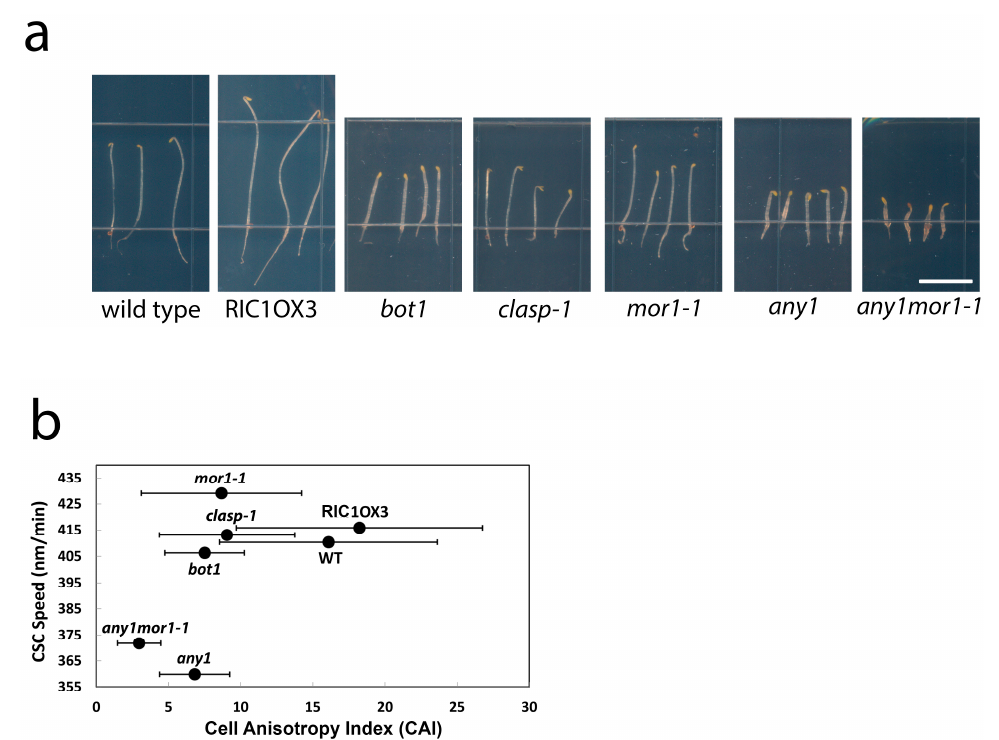
Figure 5. Moderate CSC speed is required for cell growth anisotropy. ( a ) Images of 3-day-old dark-grown seedlings at 29 °C used in anisotropy measurements; ( b ) CSC speed and cell anisotropy index (CAI) of the various analyzed genotypes were plotted. CAI was calculated as the ratio of the length divided by width of the hypocotyl epidermal cells. Wild-type CAI = 16.1 ± 7.6 ( n = 60). mor1-1 CAI = 8.6 ± 5.6 ( n = 49). any1 CAI = 6.8 ± 2.5 ( n = 82). bot1 CAI = 7.5 ± 2.8 ( n = 61). RIC1OX3 CAI = 18.2 ± 10.4 ( n = 92). any1mor1-1 CAI = 3.3 ± 1.5 ( n = 181). clasp-1 CAI = 9.0 ± 4.7 ( n = 99). CSC speed was